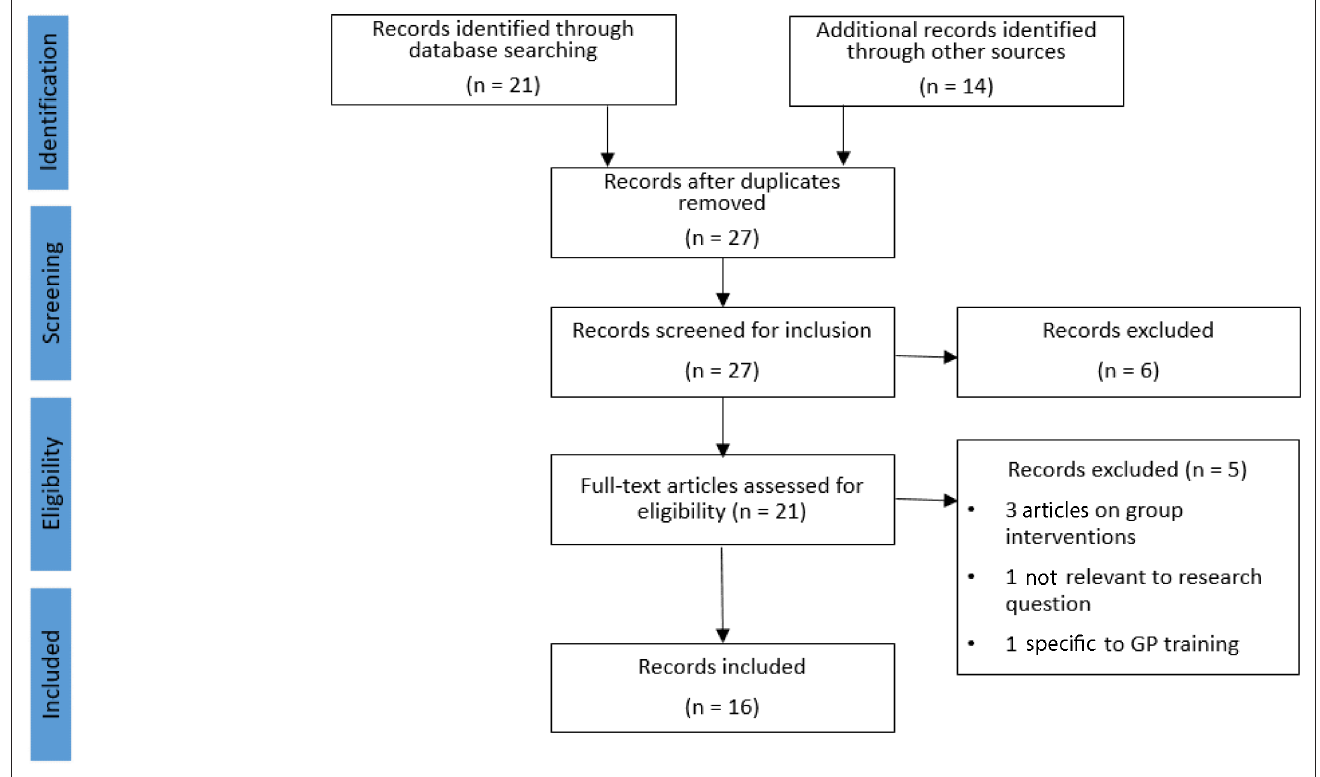
Figure 1 PRISMA flow